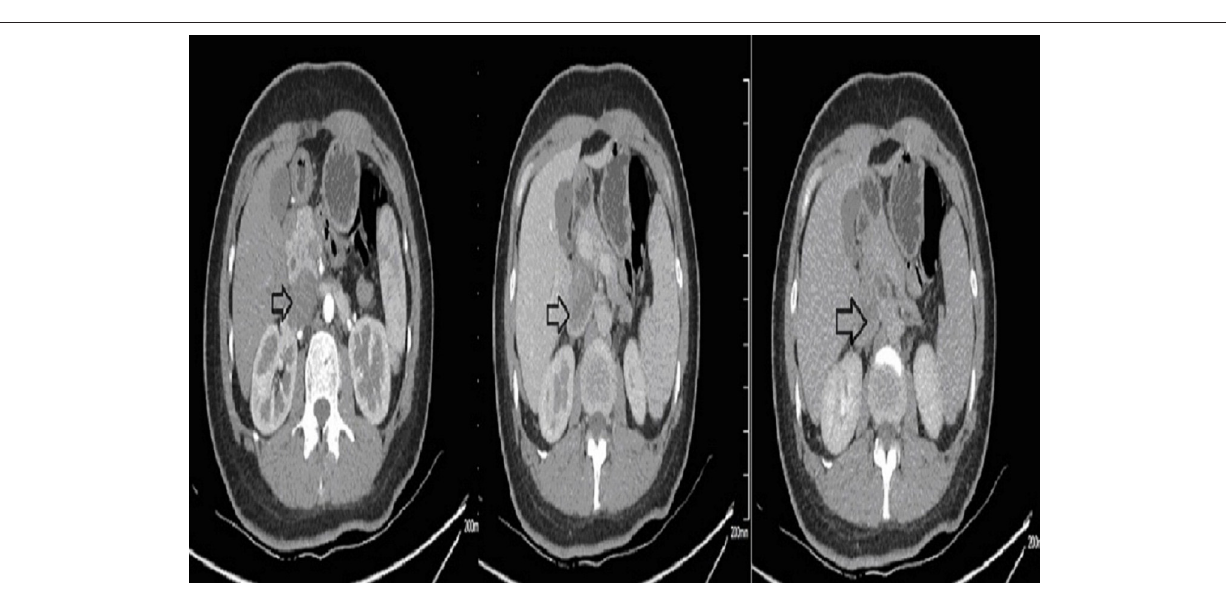
FIGURE 2 | Preoperative contrast-enhanced CT images. The border between the tumor and IVC was